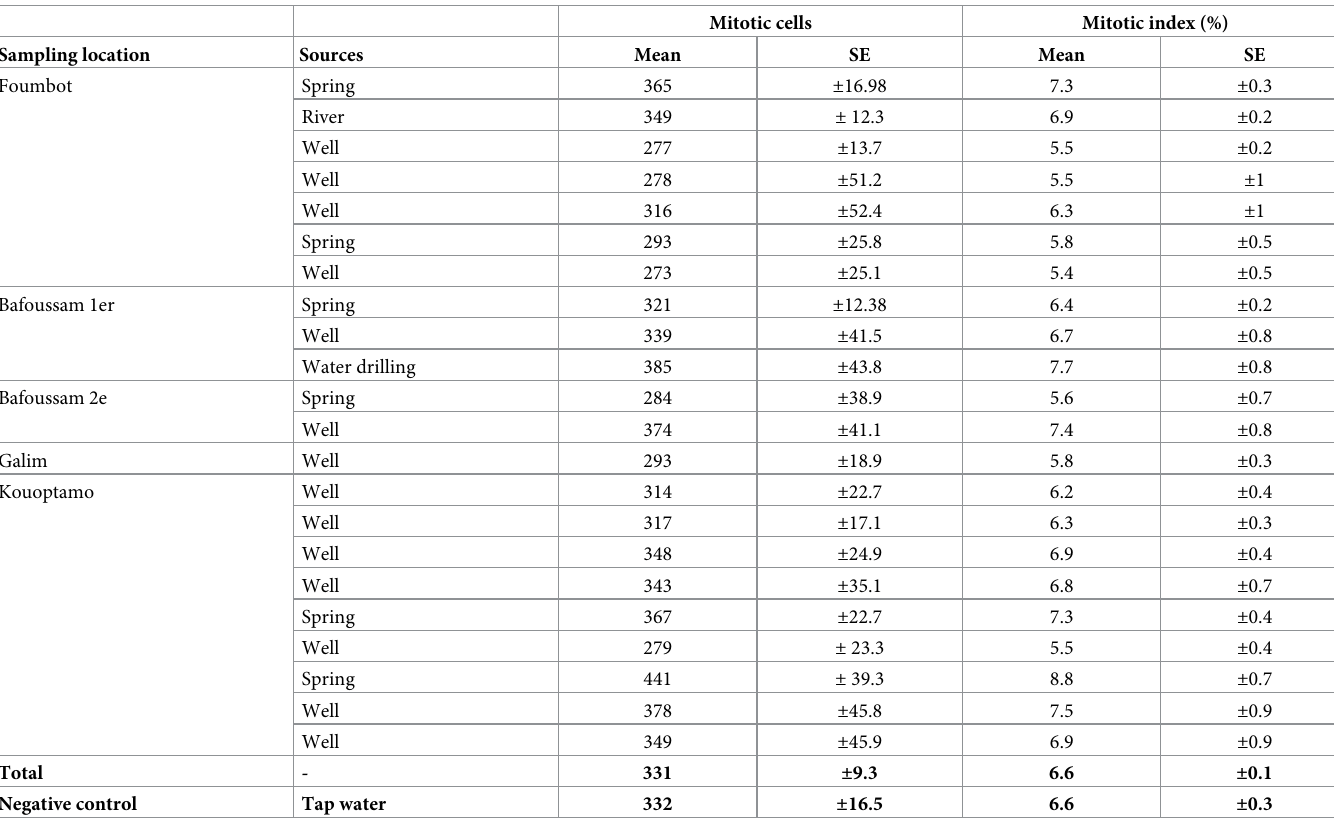
Mitotic cells Mitotic index (%)